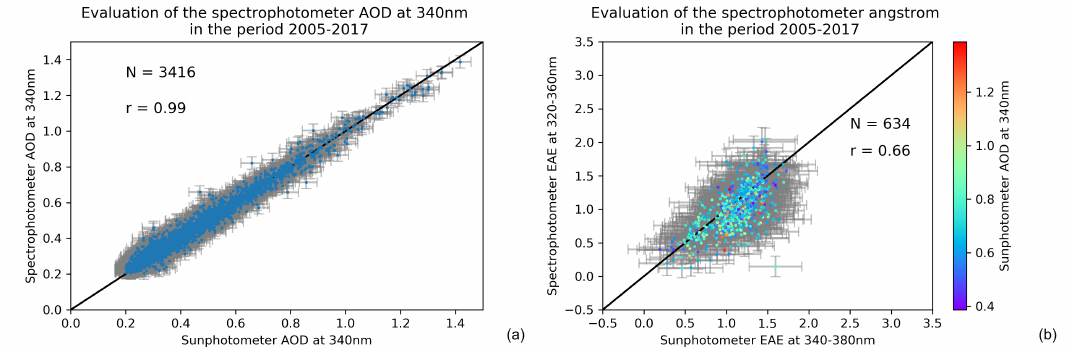
Figure 1. Point by point comparison of the AOD340 obtained from the Brewer and the CIMEL ( a ). The EAE320-360 product from the Brewer is compared with the EAE340-380 from the CIMEL on the right. The uncertainties for all products are included. The AOD340 levels of the CIMEL are also visible in the EAE comparison ( b